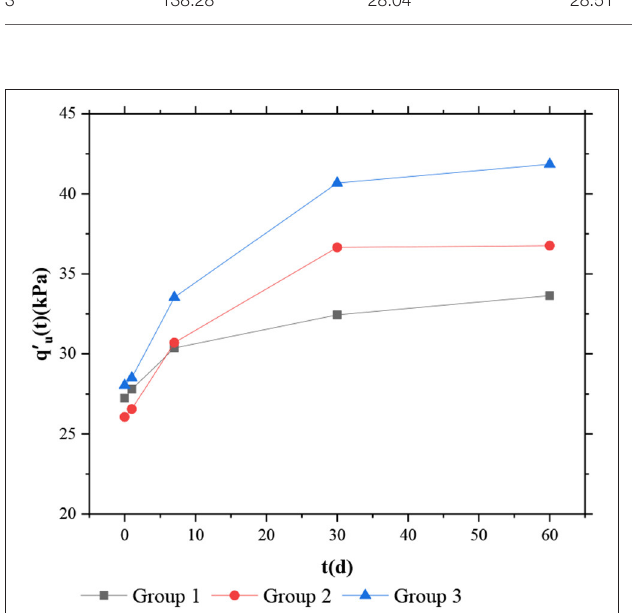
FIGURE 2 | Curve of relationship between unconfined compressive strength and curing time of remolded soil samples.